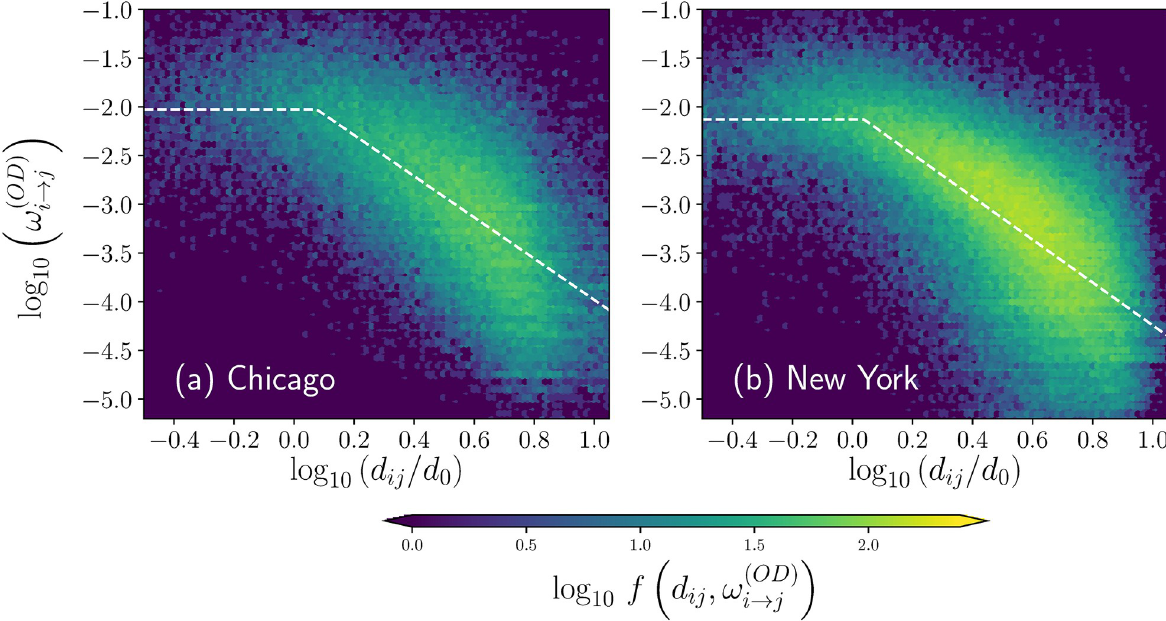
Fig 4. Probabilities of transition between stations. We explore the relation of the probability of transition o ð OD Þ distance d between stations i and j for the activity of BSS users in (a) Chicago and (b) New York. We present hexagonally binned two-dimensional ij and the logarithm of d ij / d 0 where d 0 = 1 Km is a reference distance. Dashed lines depict the best fit described histograms for the logarithm of o ð OD Þ � � � � i ! j d ij by Eq (4) for the pairs log ; log with i , j = 1, 2, ... , N . The values codified in the colorbar represent the frequencies f ð d w ð OD Þ i ! j 10 10 d 0 in each hexagonal bin and presented as a